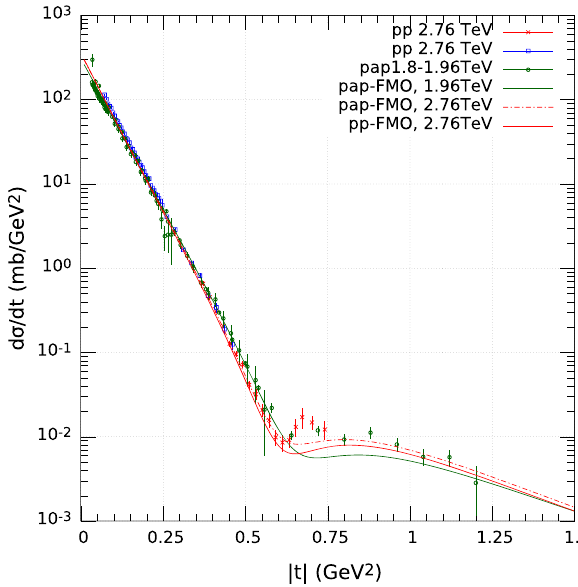
Fig. 16 ¯ pp differential cross section at 1.18–1.96 TeV and pp differ- ential cross section at 2.76